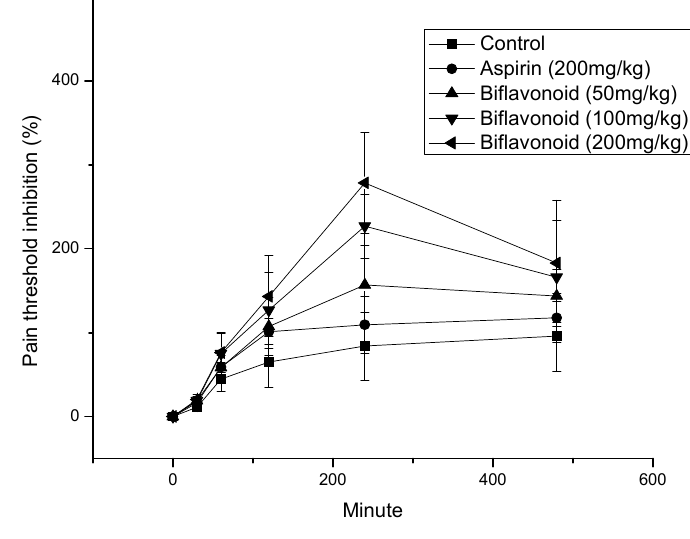
Figure 2. Inhibition of pain threshold in hot plate test of mice by different treatment. Values represent means ± SD ( n =